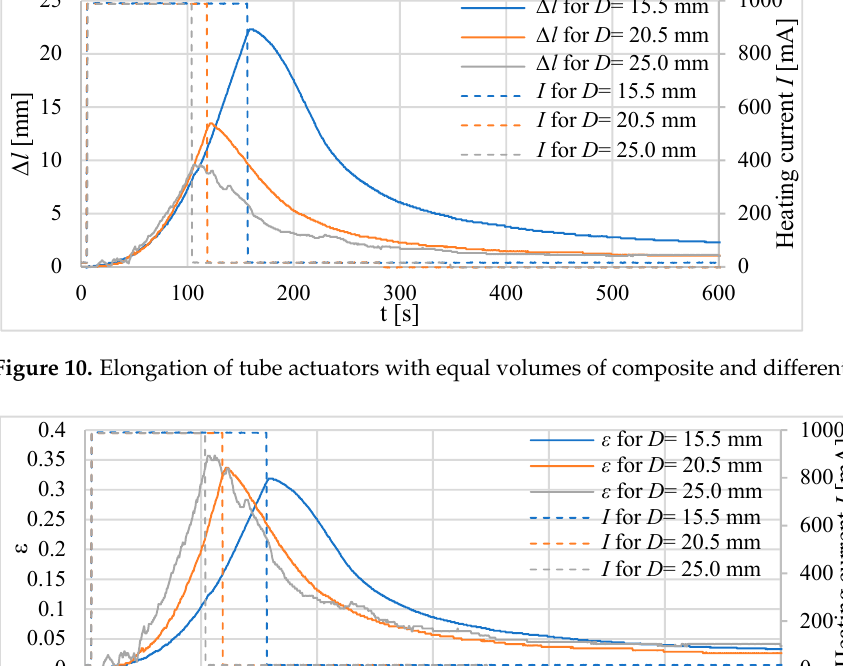
Table 3. The parameters and results of tube actuators with equal volume. Figure 11. Relative elongation ε of tube actuators with equal volumes of composite and different diameters.